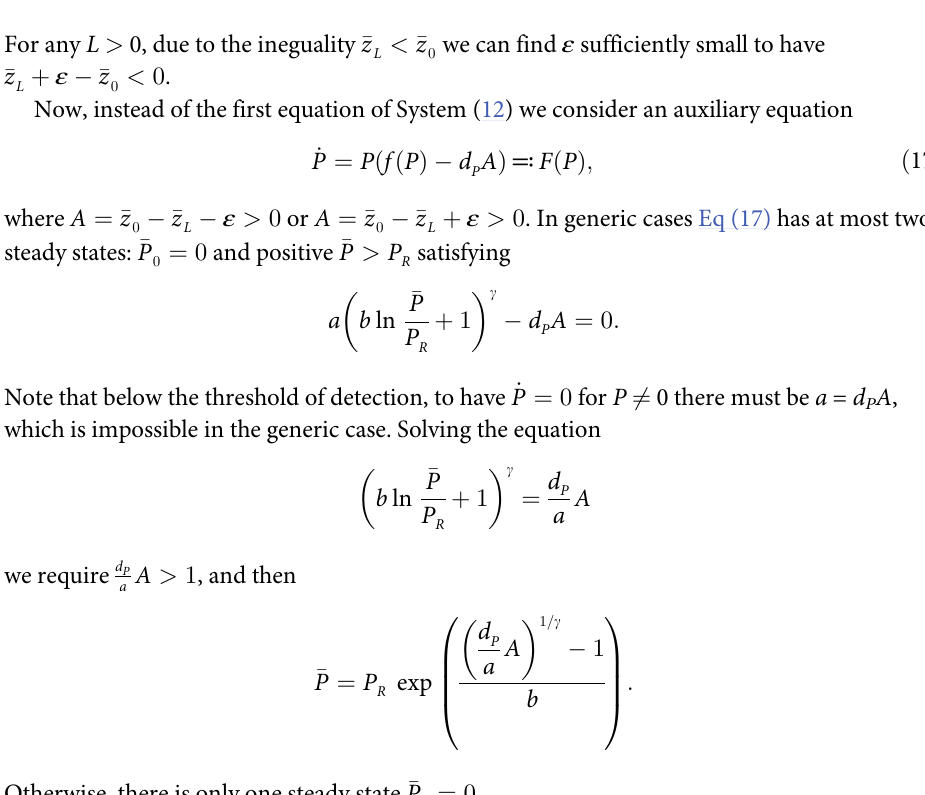
Fig 7. Phase portraits for System (12) with parameters as in Fig 6; L = 0 (top left), L = 0.5 (top middle), L = 2 (top right), L = 9 (bottom left), L = 19 (bottom middle), L = 49 (bottom right).